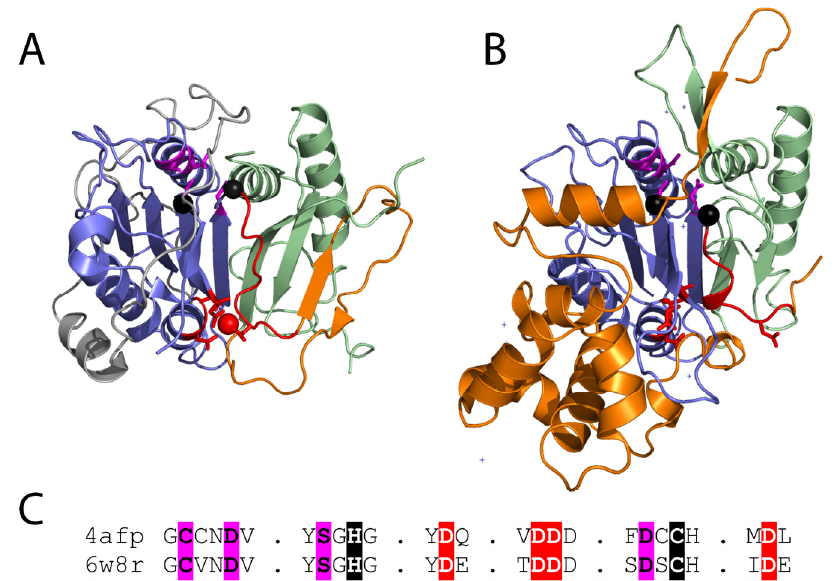
Figure 3. ( A ) Metacaspase from T. brucei (PDB 4afp) bound to a calcium mimetic (red sphere) with coordinating residues (red sticks) highlights the Ca 2+ activation loop (red cartoon) that is followed by a variable sequence (orange cartoon) of different lengths that adopts diverse conformations in fungal metacaspases. Active site residue positions (black spheres) are near the P1 binding site (magenta sticks). The p20 and p10 subunits are colored blue and green, respectively, and the N-terminal extension is colored white. ( B ) Inactive AtMC4 structure (PDB 6w8r) is colored as in panel A. Multiple inserts to the structure are in white. ( C ) Corresponding motifs from the experimental structures are aligned. Functional residues are highlighted: Ca 2+ binding (red), catalytic (black), and P1 pocket (magenta).